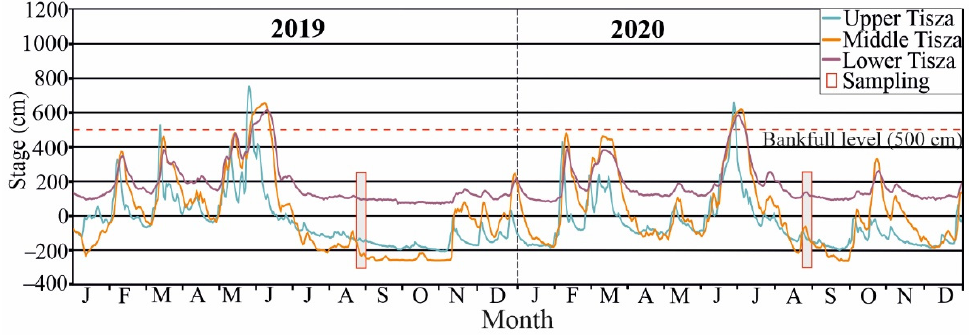
Figure 3. The sampling campaigns were performed in August 2019 and 2020. The sampled sediments were deposited by an early summer flood wave.